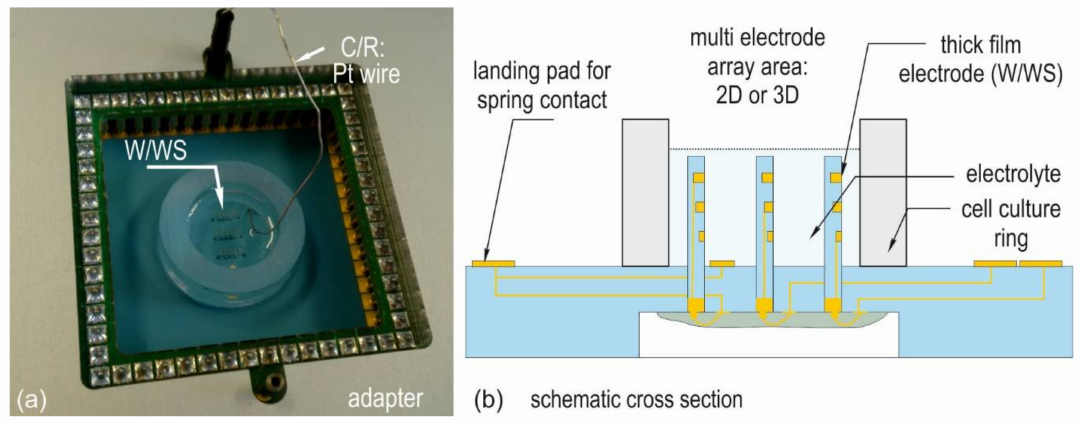
Figure 3. ( a ) LTCC chip mounted in the impedance measurement adapter; ( b ) cross section of the measurement set-up.